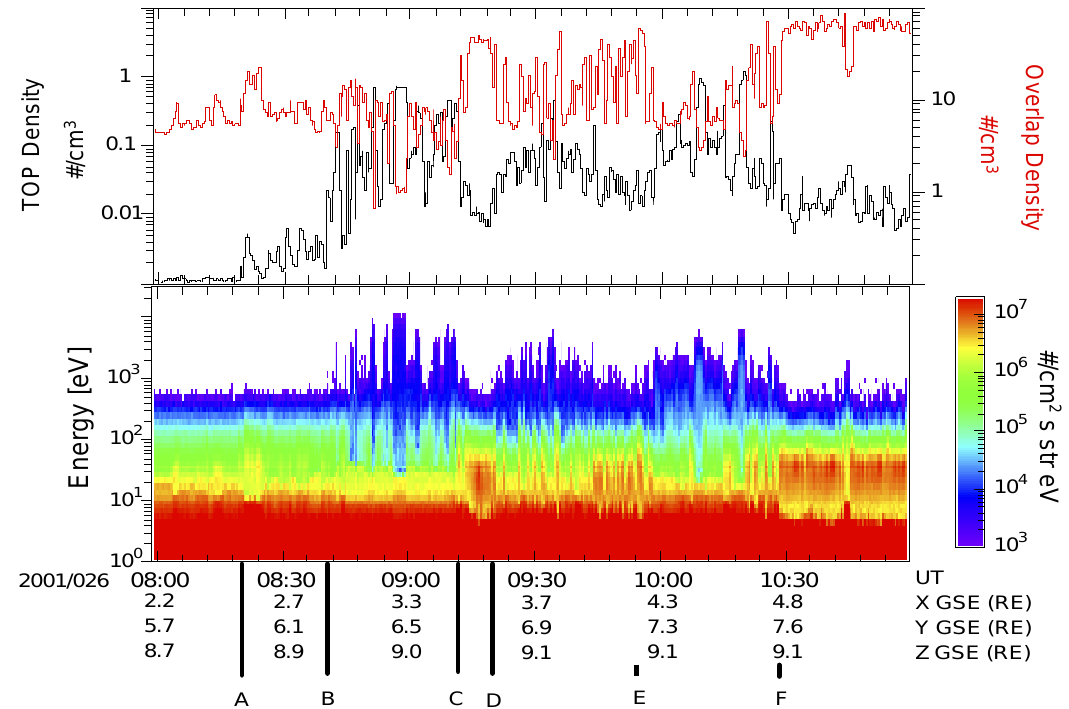
Fig. 4. The density moments and energy spectra from 26 January 2001, 08:01–11:50 UT. The upper panel shows density from the Top energy region in black and the Overlap energy range in red. The spectrogram is a combination of the HEEA and LEEA sensor, measured in a differential number flux (#/cm 2 s streV). We note the large band of photoelectrons below ∼ 10eV.